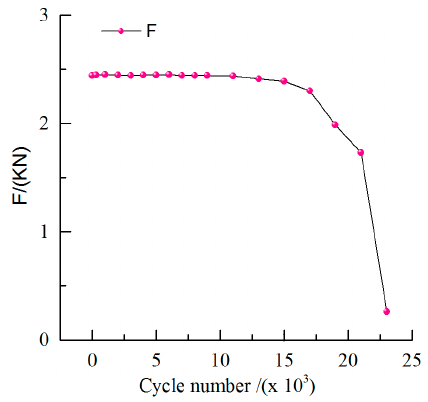
Figure 5. The variation of max loading value “F” at different fatigue cycles.